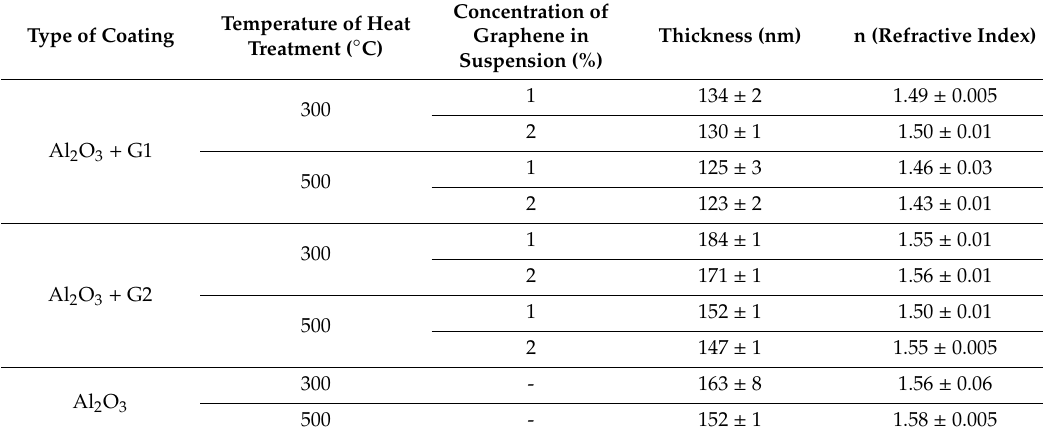
Table 1. The thickness of coatings deposited on steel